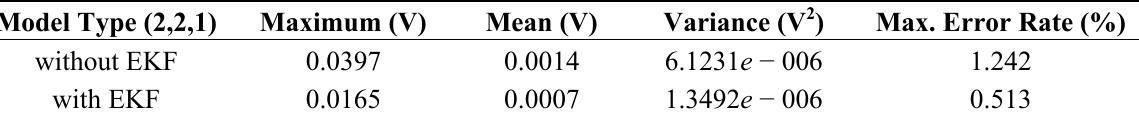
Table 6. The statistic analysis list of the absolute values of terminal voltage errors.